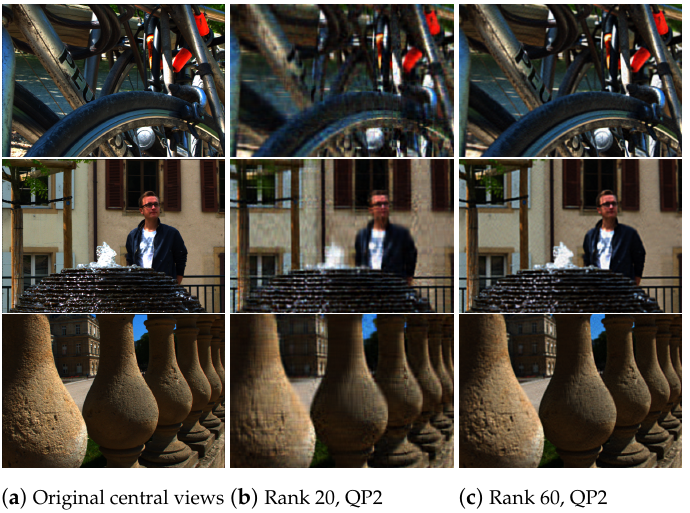
Figure 10. Comparison of the original and reconstructed views. ( a ) Original central views of the three datasets; ( b ) reconstructed central views using our proposed scheme for rank 20 and QP 2; ( c ) reconstructed central views using our proposed scheme for rank 60 and QP